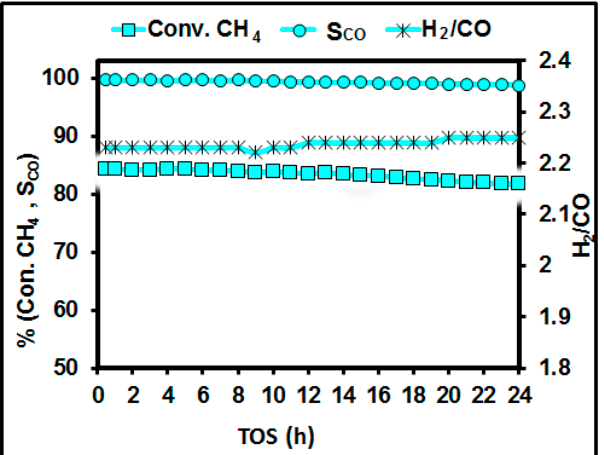
Figure 9. CH 4 conversion, CO selectivity and H 2 /CO ratio over Co-800 (5%Co/Al 2 O 3 –ZrO 2 ) catalyst calcined at 800 °C over 24 h on stream in POM at 800 °C.